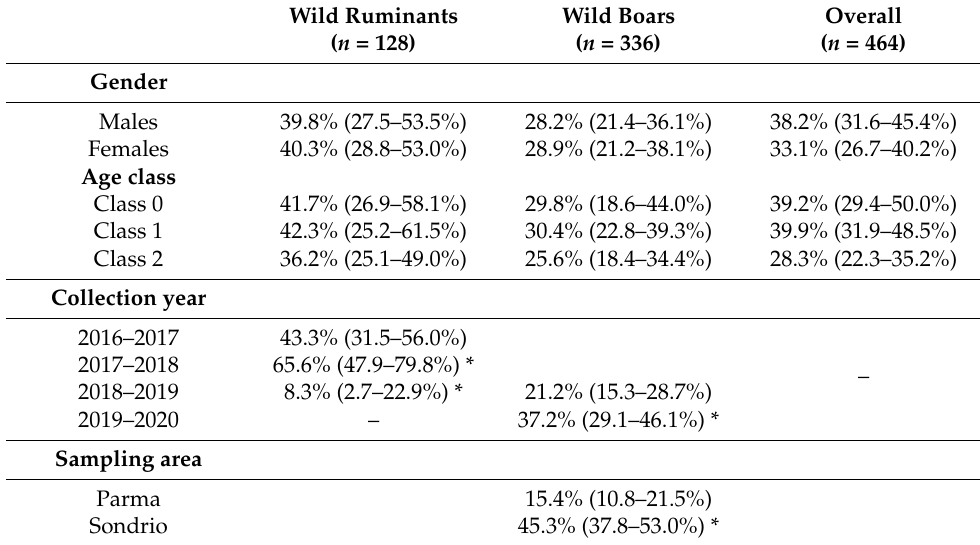
Table 6. MRV prevalence according to species, gender, age, collection year, and sampling area. Wild ruminants’ column accounts for red deer, roe deer, and chamois samples. Age class 0 refers to <1 year-old animals, age class 1 to animals between 1 and 2 years old, and age class 2 to animals >2 years old. In brackets 95% CI.